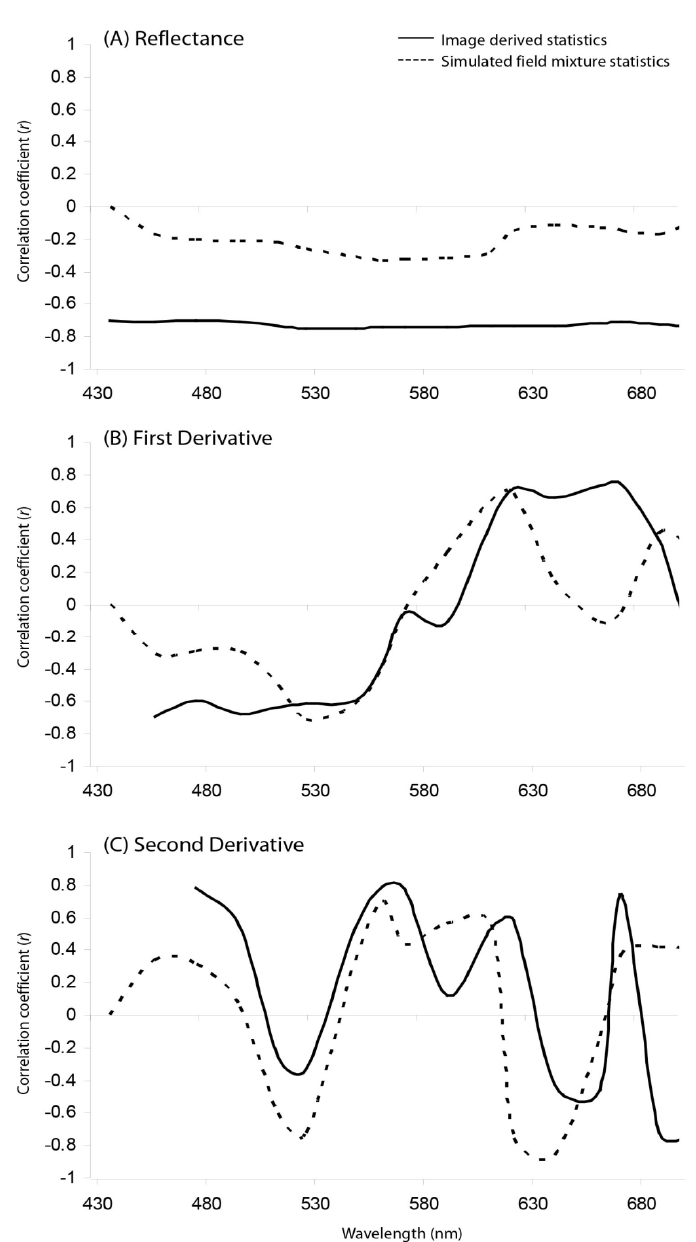
Figure 8. Comparison of field spectrometer simulations with applied CASI-2 image data-linear correlations for relationship between live coral and ( A ) reflectance; ( B ) first derivative; and ( C ) second